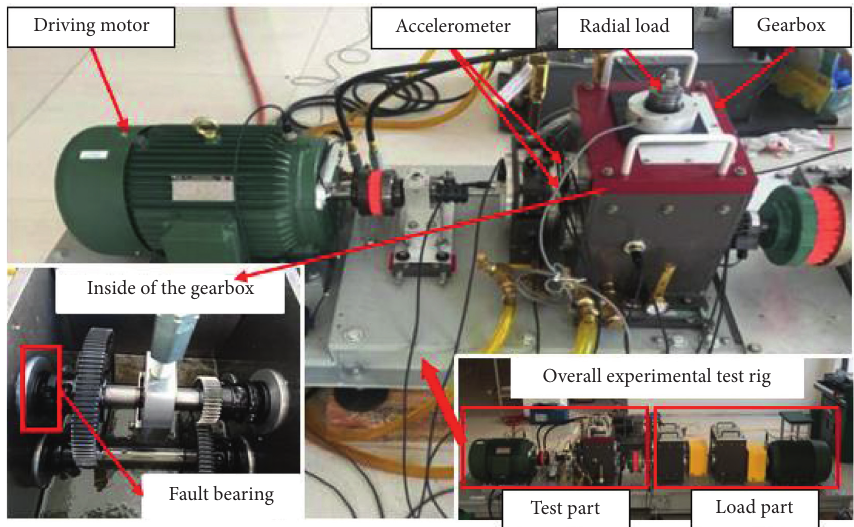
Figure 7: Schematic diagram of experimental